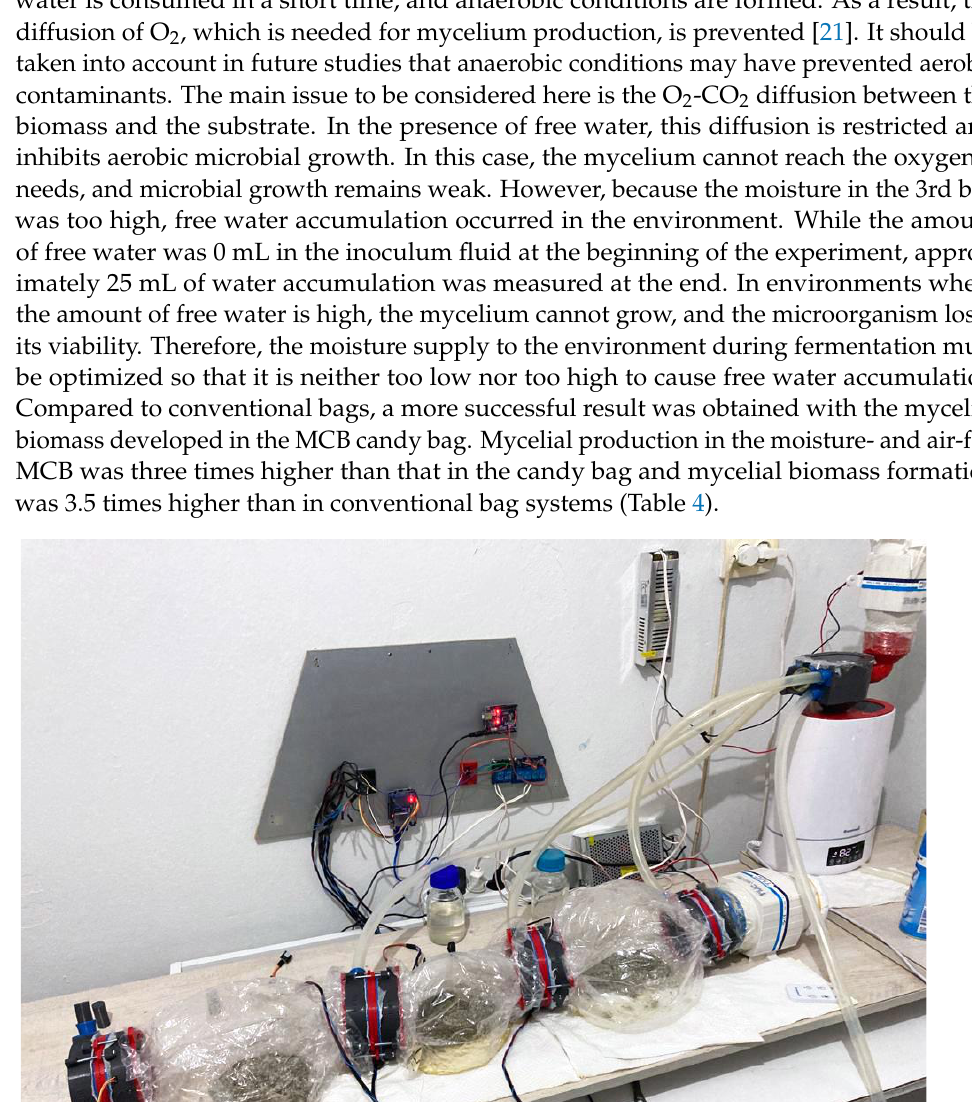
8 of 12 Table 3. Contaminant control experiment assay. Bag